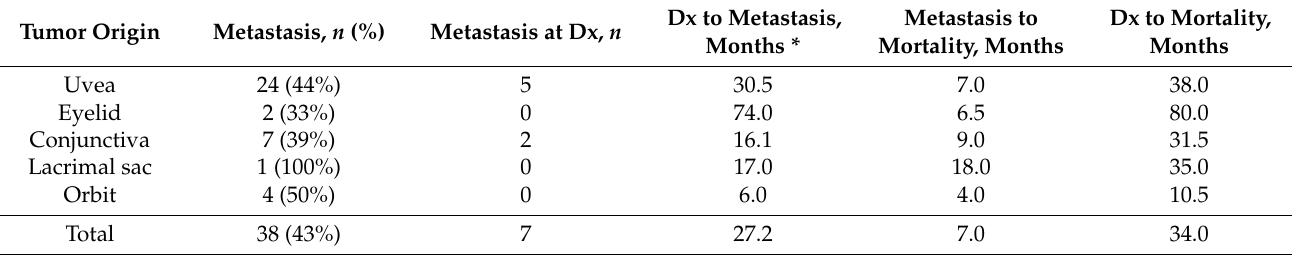
Table 3. Metastasis, mortality, and the time